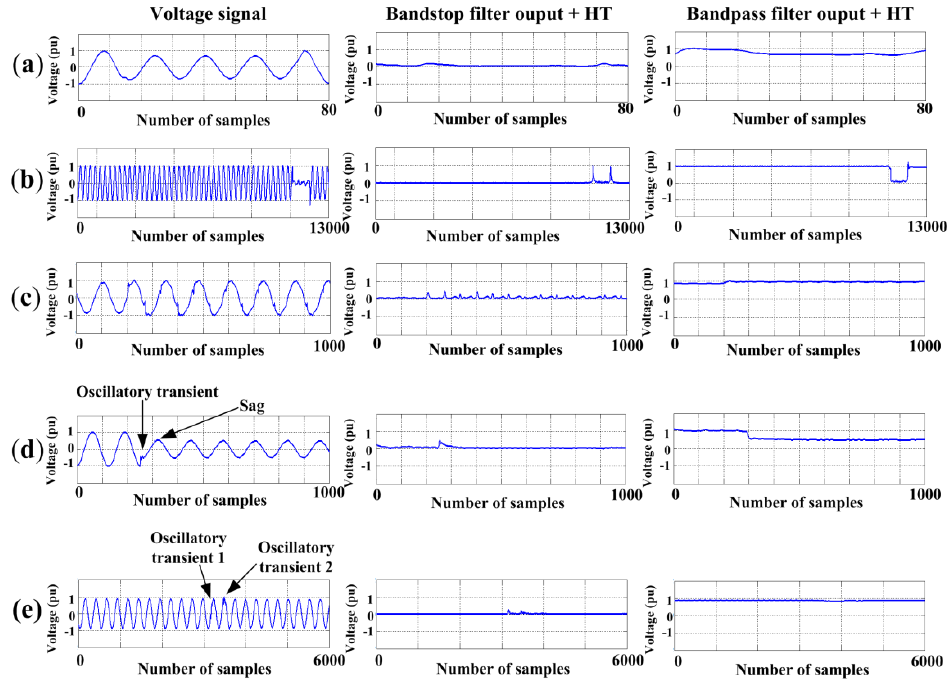
Figure 9. Real signals of PQD. ( a ) Sag (overhead insulator failure); ( b ) Interruption (overloaded transformer); ( c ) Spikes (splice failure on the aerial cable); ( d ) Oscillatory transient and sag (terminator failure on the cable dip); ( e ) Two oscillatory transients (cable fault on the underground portion).